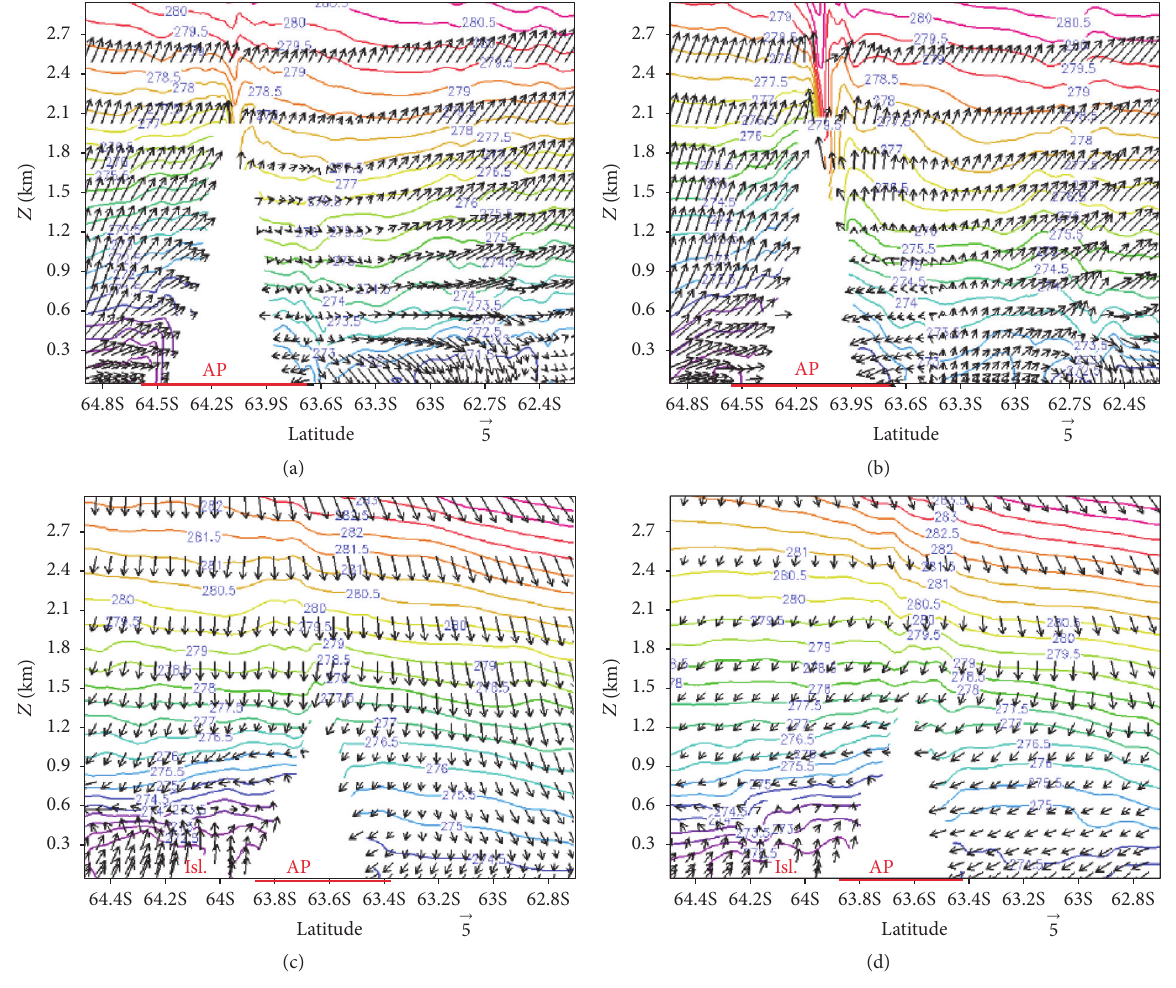
Figure 10: Vertical variation of wind vector and potential temperature for different longitudes. Latitude and height are shown in 𝑥 - and 𝑦 - axes. (a, b) represent a cross section at longitude 59.1 W, while (c, d) are at 58.45 W. Time of the panels is as follows: (a) 15 December 2013 at 19:00 UTC; (b) 15 December 2013 at 22:00 UTC; (c) 24 December 2013 at 20:00 UTC; and (d) 24 December 2013 at 23:00 UTC. The white area in the bottom corresponds to the topography at the respective longitude, while the width of the peninsula (AP) is marked with a red thick line.